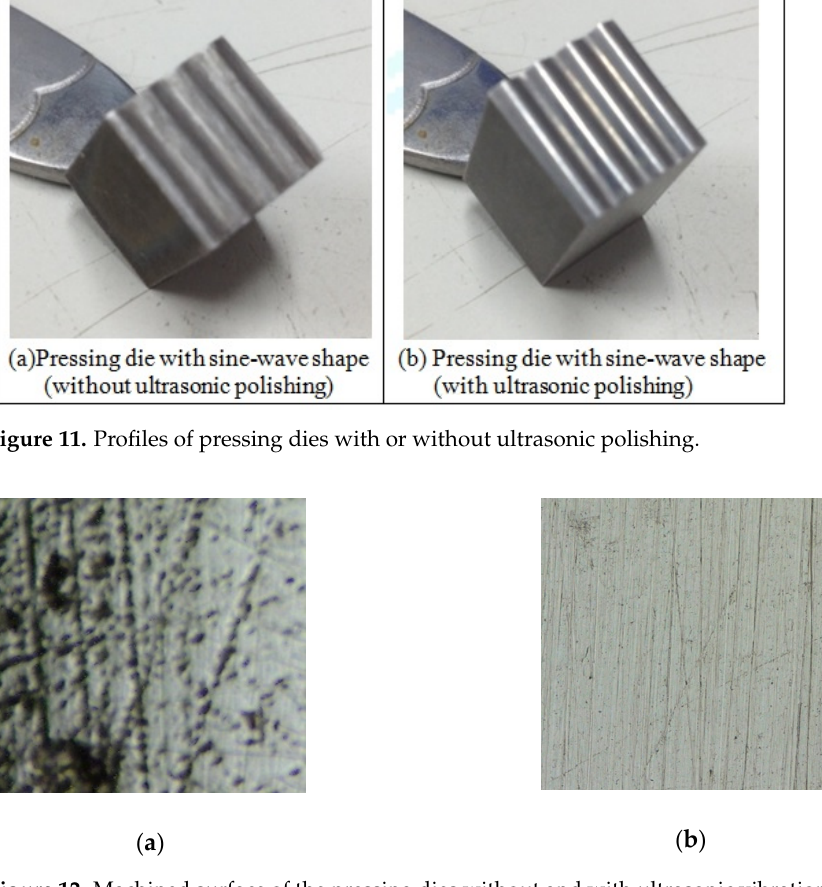
Figure 12. Machined surface of the pressing dies without and with ultrasonic vibration: ( a ) machined surface without ultrasonic vibration; ( b ) polished surface with ultrasonic vibration.